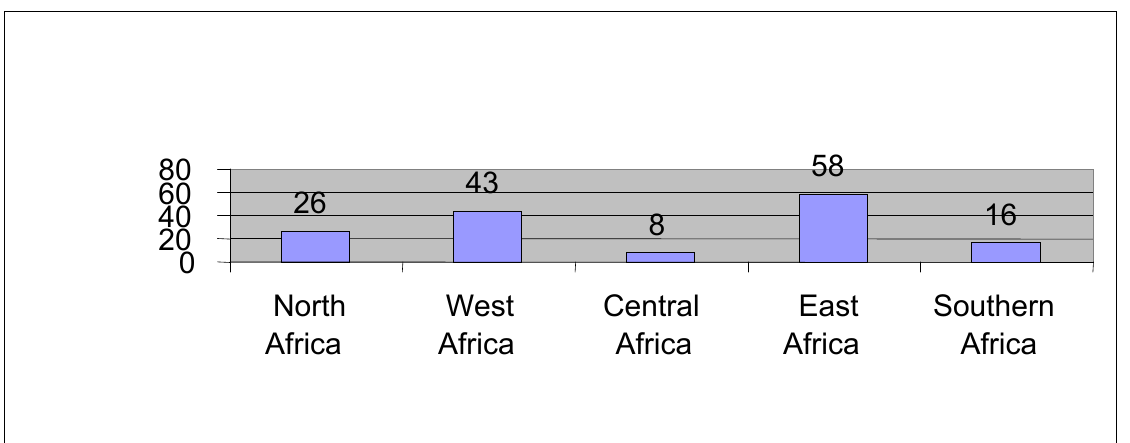
Figure 7: Disasters with economic damage in Africa: 1974 to 2003